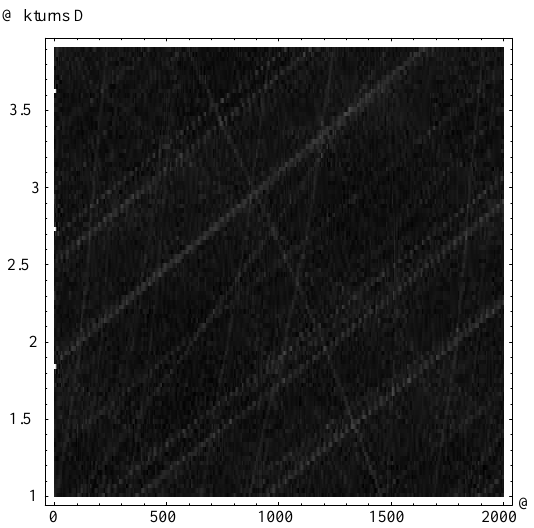
FIG. 3. 2.3 3 10 12 protons, one trace each 30 turns, vertical span 5 ms.